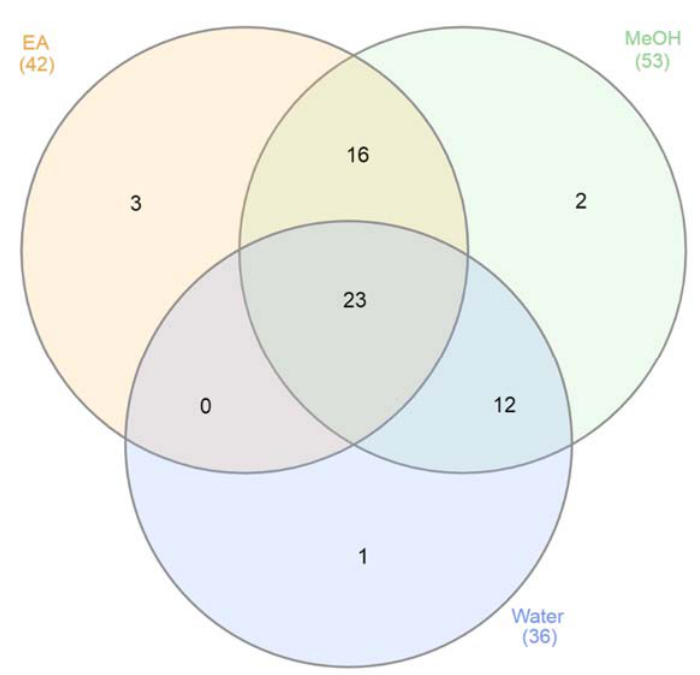
Figure 1. Venn diagram of identified compound numbers in all tested extracts.